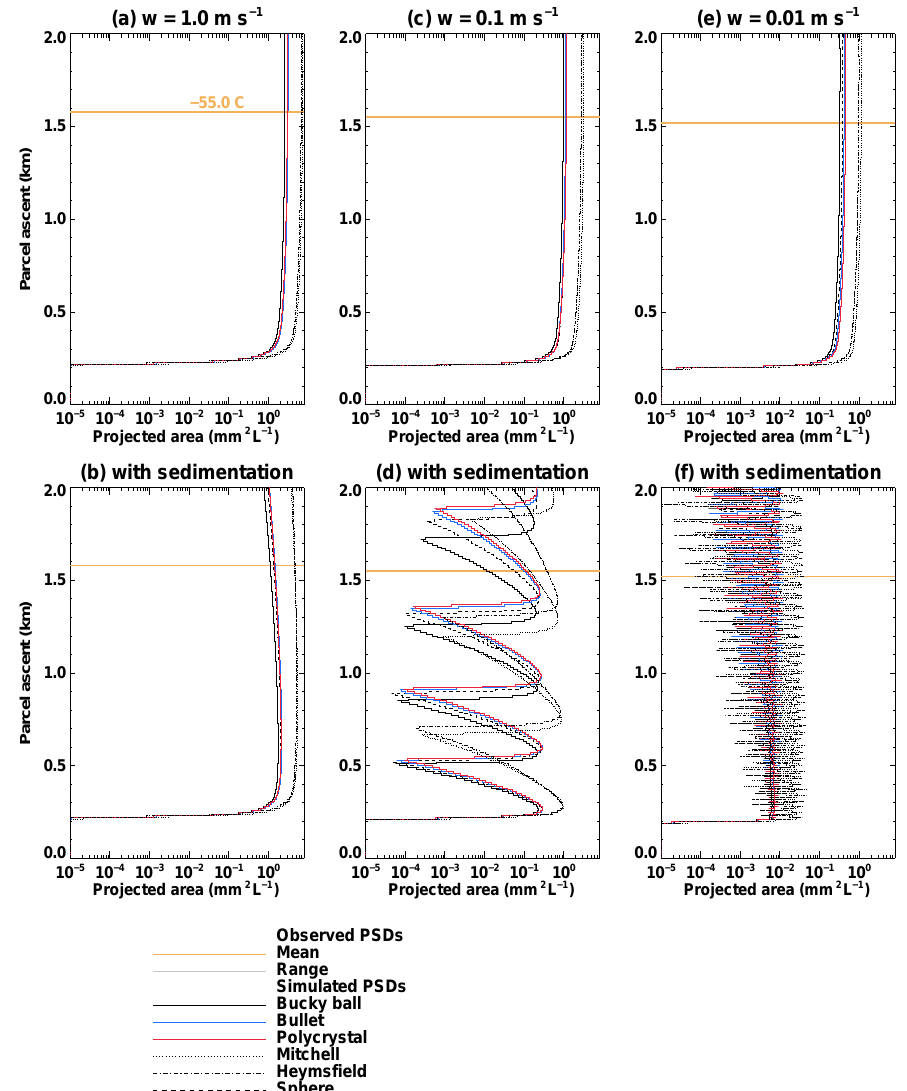
Figure 20. As in Fig. 18 except total ice crystal projected